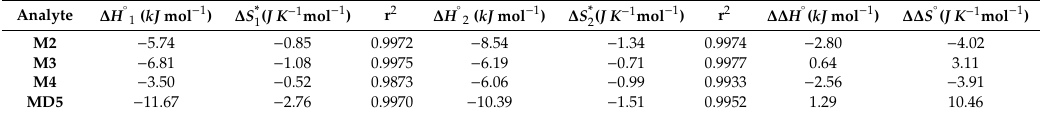
Table 2. The thermodynamic parameters for the enantioseparations of studied compounds.